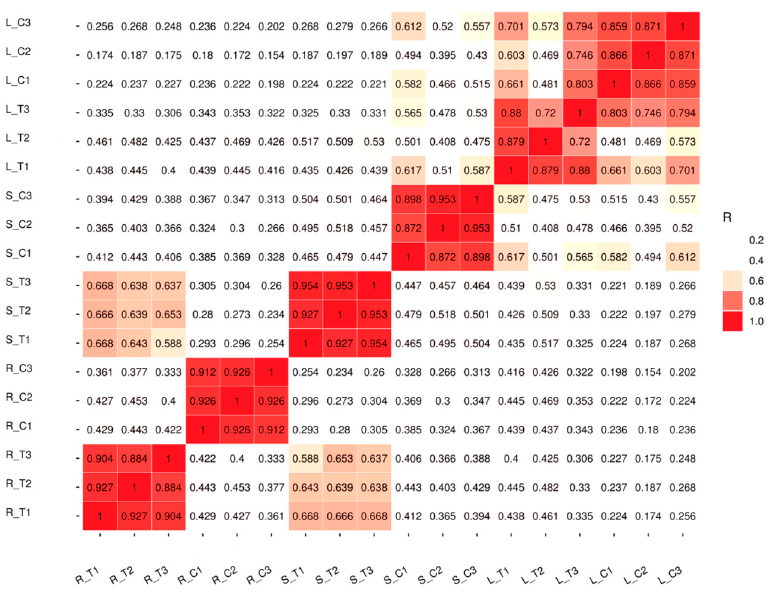
Figure 2. Pearson correlation between samples. R_T1: Root Cd treatment 1, R_T2: Root Cd Table